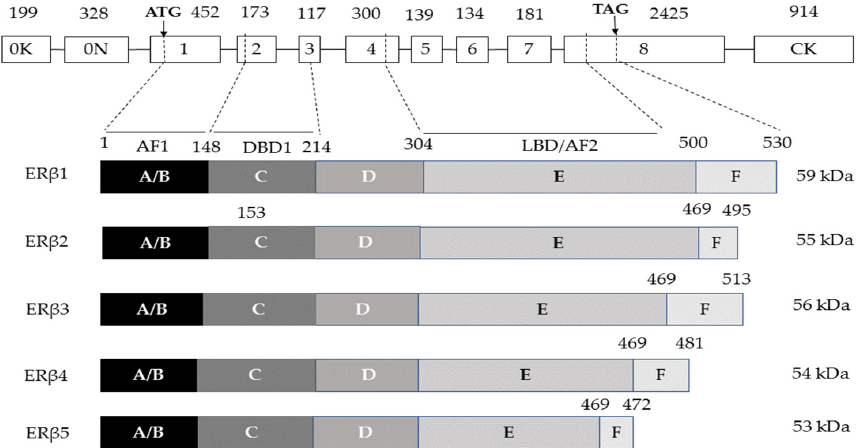
Figure 1. ESR2 gene and its five protein isoforms are represented schematically. Exons 1–8 are de- picted by boxes, exons 0K and 0N are two promoters at the gene ’ s 5 ′ end, and introns are represented by lines. Numbers above the boxes indicate the size (bp) of each exon, arrows point to the start (ATG) and stop (TAG) codons, and dotted lines connect the gene regions to the protein domains or isoforms that are encoded, from N-terminus to C-terminus, A/B: activation function 1 (AF1) domain, C: DNA-binding domain (DBD), D: hinge domain, E: ligand-binding domain (LBD) or activation function 2 (AF2) domain, F: C-terminal domain. The molecular weight of each isoform in kDa is shown by the numbers on the right side. The figure is adapted from[54].